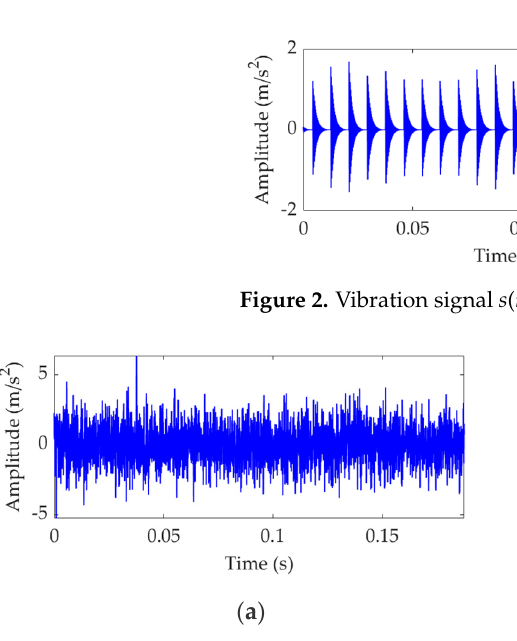
Figure 3. The simulated vibration signal x ( t ): ( a ) time − domain waveform and ( b ) SES.